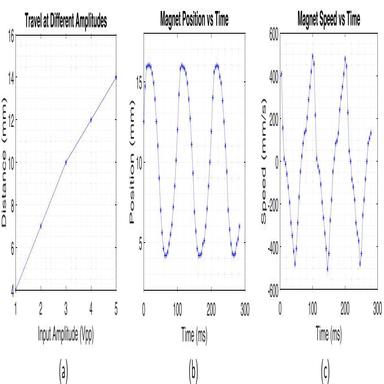
Moving magnet tests (Type 2): a) travel distance of the vibration exciter vs input amplitude for 10 Hz; b) exciter position versus time for 4 Vpp with s 10 Hz excitation and 12 mm travel distance; c) speed vs time of the exciter.